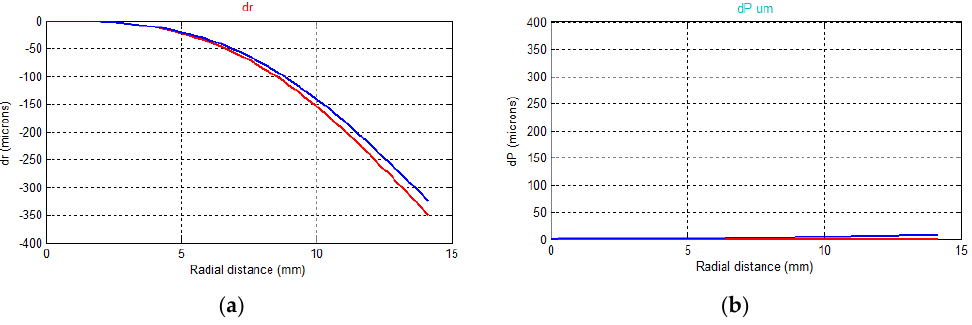
Figure 14. ( a ) Radial and ( b ) decentering distortion curves: the curves in red are related to the camera calibration in air, the curves in blue to the camera calibration underwater.